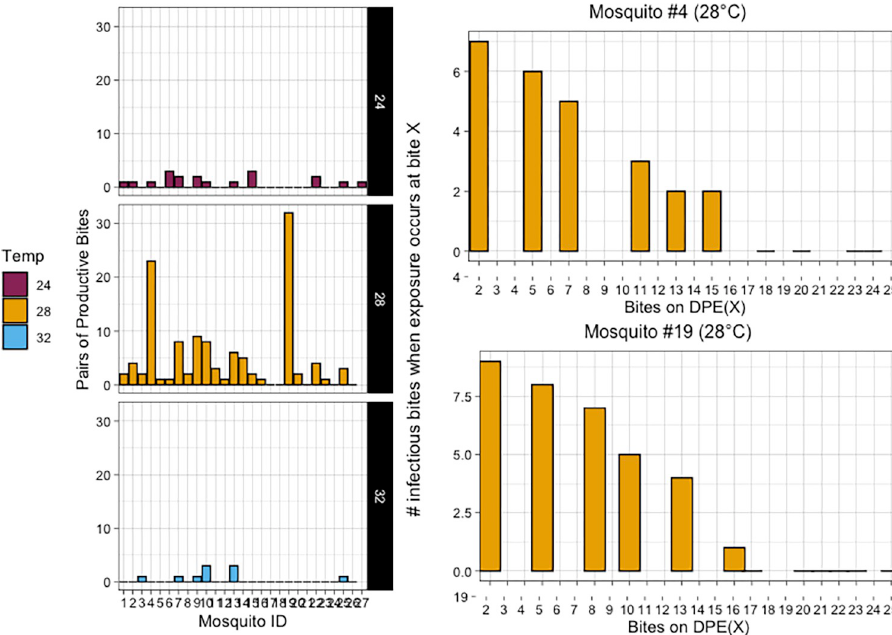
Fig 4. Left: At each temperature, the number of pairs of bites for each mosquito (x–axis) that are separated by at minimum the temperature dependent EIP. Right: Two representative mosquitoes from 28˚C with high frequency of biting demonstrating the number of bites occurring after the temperature dependent EIP (histogram) corresponding to each bite (black and white bars below).